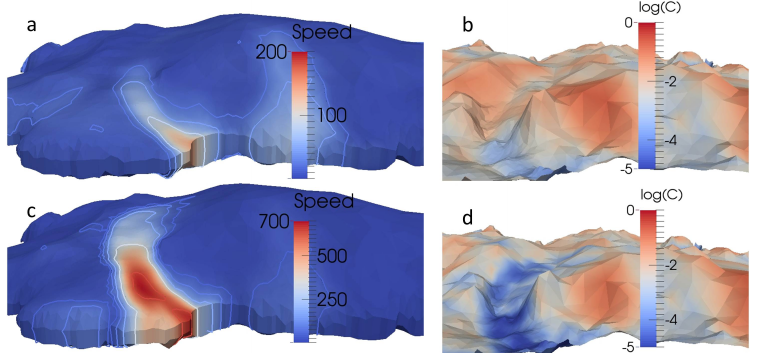
Figure 4. 3-D view of ASF showing the mesh refinement over the B3 outlet glacier, just left of centre. Vertical exaggeration is 30 times.